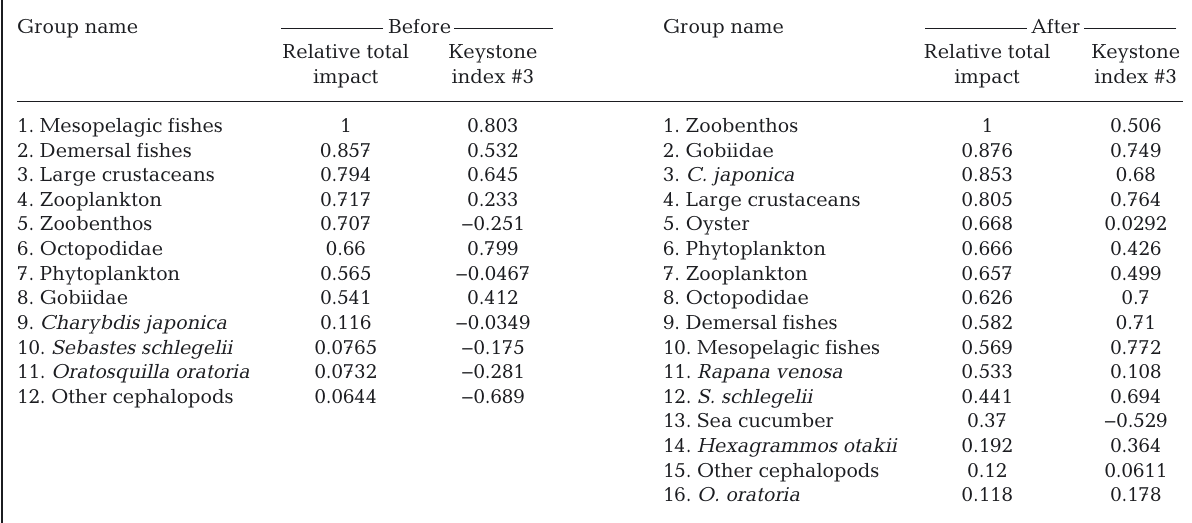
(Table 2). Detritus production (2530.825 t km − 2 ) rep- resented the largest portion (73.82%) of overall PPR (Table 2). The sea cucumber showed the lowest PPR/catch value (5.6) among functional groups, indi- cating fishing catch biomass values close to primary production values (Table